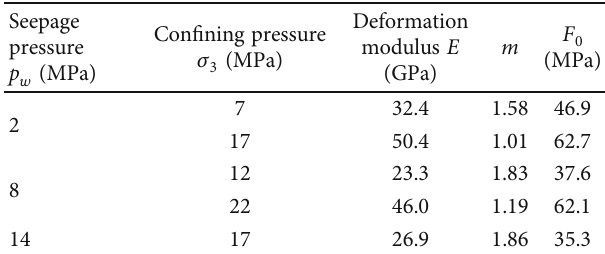
Figure 3: Comparison between experimental and calculated curves for limestone at di ff erent con fi ning pressure and seepage pressure: (a) seepage pressure 2MPa and con fi ning pressure 7MPa, (b) seepage pressure 2MPa and con fi ning pressure 17 MPa, (c) seepage pressure 8MPa and con fi ning pressure 12 MPa, (d) seepage pressure 8 MPa and con fi ning pressure 22 MPa, and (e) seepage pressure 14MPa and con fi ning pressure 17 Table 3: Model parameters.